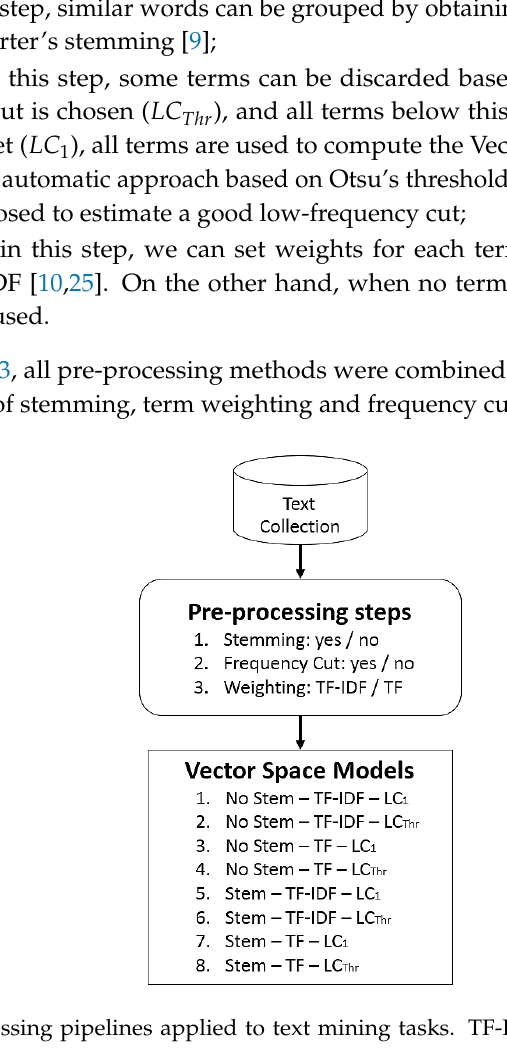
Figure 3. Pre-processing pipelines applied to text mining tasks. TF-IDF, Term Frequency-Inverse Document